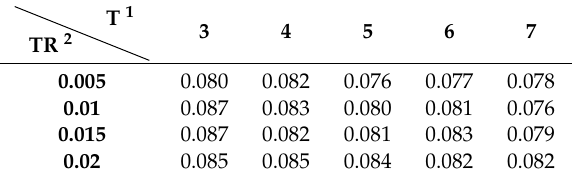
Table 3. ATOP80 values of di ff erent slope numbers and di ff erent range thresholds. T 1 3 TR 2